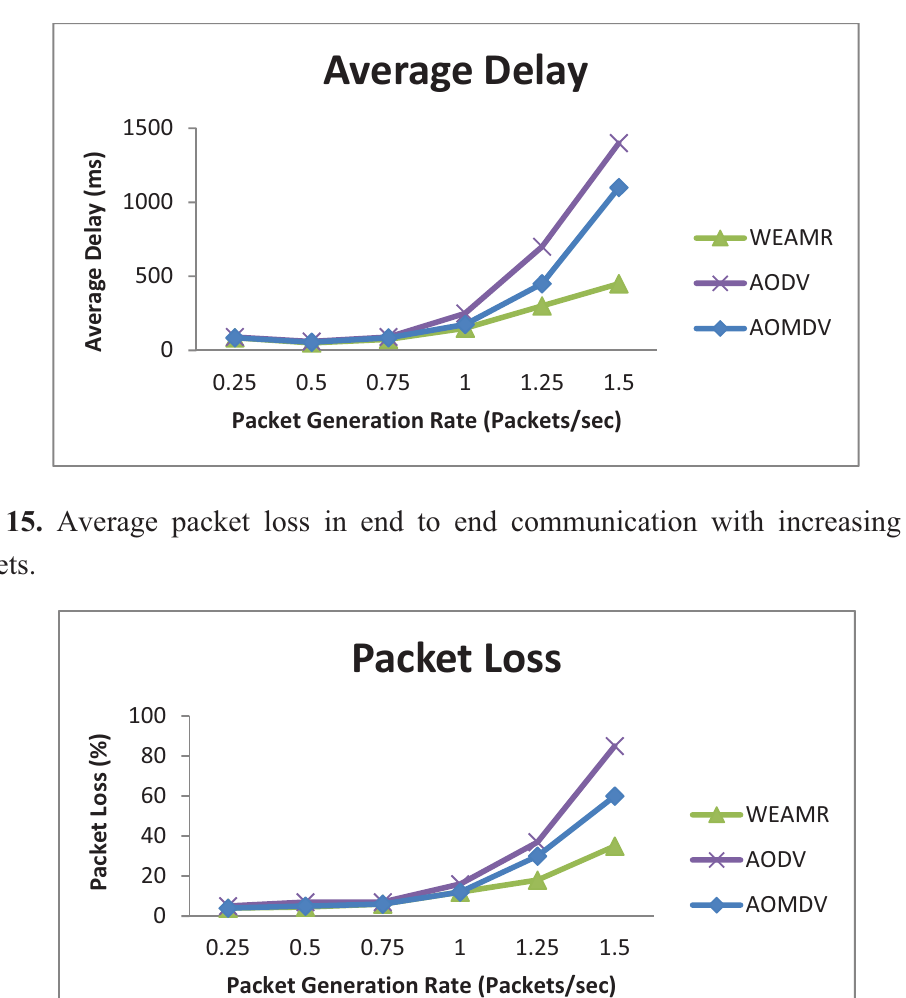
Figure 14. Average end to end delay with increasing number of packets.